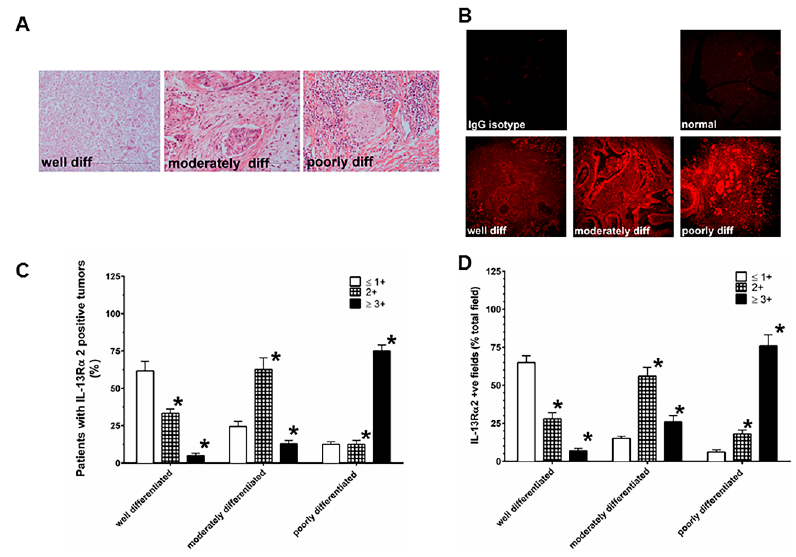
Figure 1. PDAC (pancreatic ductal adeno-carcinoma) samples are characterized by IL-13R α 2 expressing tumor cells in di ff erent pathological grades. ( A ) H&E (hematoxylin and eosin) staining of PDAC samples with well di ff erentiated, moderately di ff erentiated, and poorly di ff erentiated tumors. ( B ) Immunohistochemical analysis for IL-13R α 2 expression in PDAC and normal pancreas. ( C ) The extent of immunostaining of IL-13R α 2 in PDAC was evaluated at three levels between 0 and 3 + according to the intensity of staining. ( D ) Percent positive fields expressing IL-13R α 2 were counted in samples with di ff erent pathological grades. Normal pancreas showed negative staining for IL-13R α 2 expression. The samples were viewed at 200 × magnification. * p =